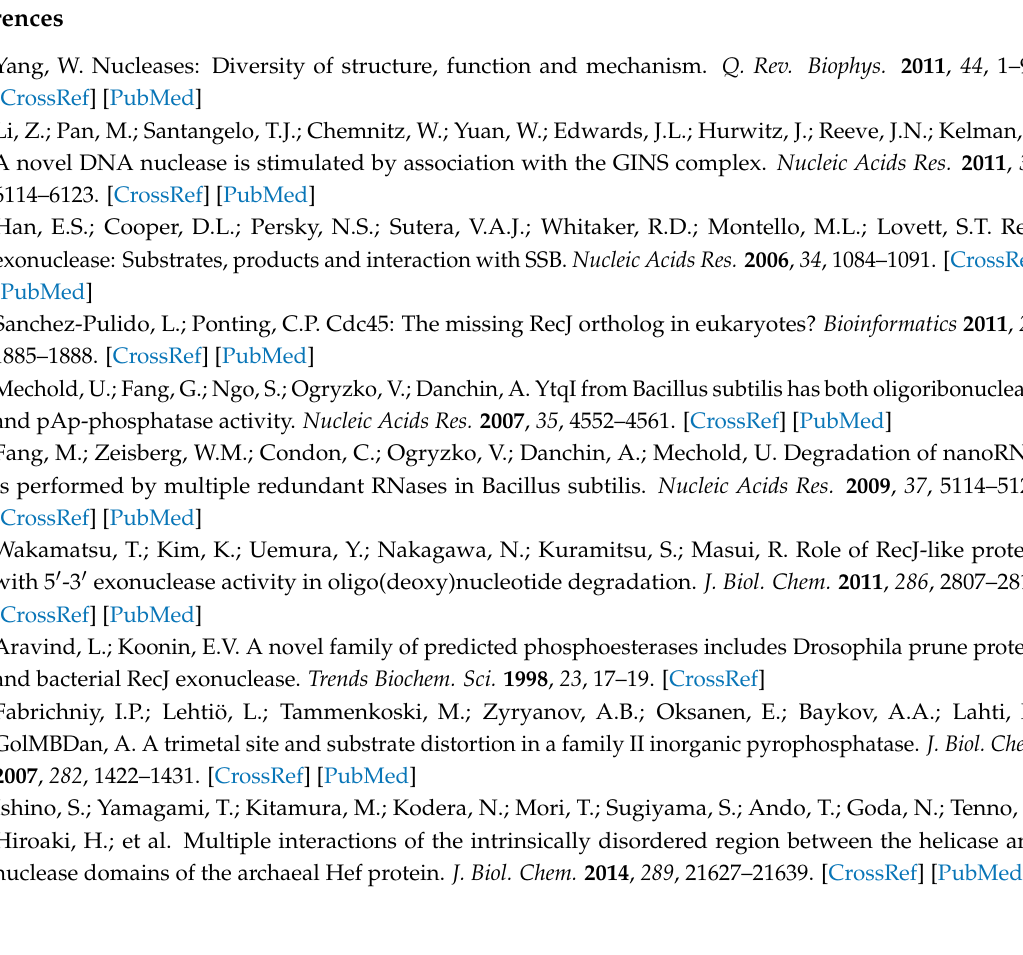
Supplementary Materials: The following are available online at www.mdpi.com/2073-4425/8/9/211/s1. Figure S1 Biochemical characterization of MjaRecJ1. Figure S2 Biochemical characterization of MjaRecJ2. Figure S3 Thermostabilities of MjaRecJs. Figure S4 Hydrolysis polarity of two MjaRecJs confirmed by special phosphothioate-modified substrates. Figure S5 Effect of terminal phosphate group on M. jannaschii RecJs activity. Figure S6 Interaction identification of MjaRecJs and MjaGINS. Figure S7 Effect of MjaGINS on MjaRecJs activity. Table S1 Oligonucleotides used in this